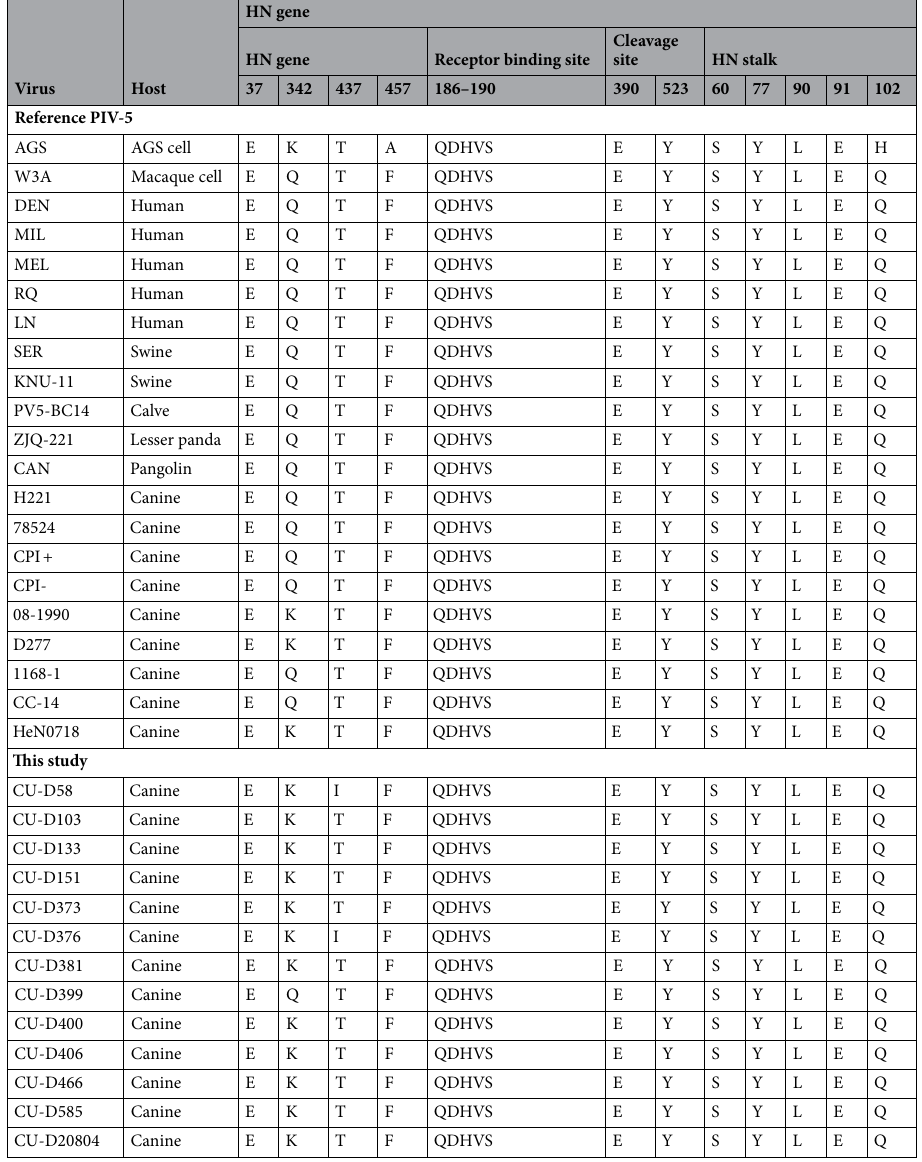
Table 3. Genetic analysis of the HN gene of Thai CPIV-5 and reference PIV-5 at the receptor binding, cleavage site and stalk